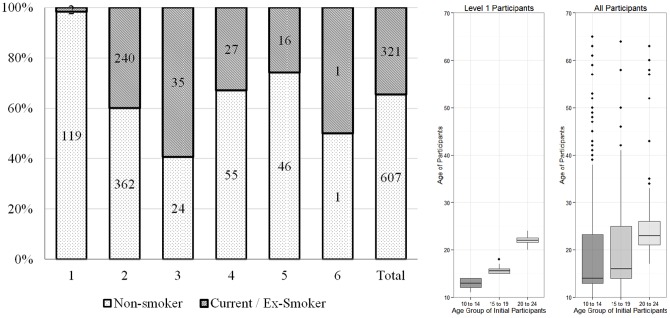
Referral process of the campaign.Left panel: number of non-smokers versus current or ex-smokers at each referral level. Right panel: Age distribution of all users in referral pathways originating from level-1 users in 10 to 14, 15 to 19, 20 to 24 age groups.